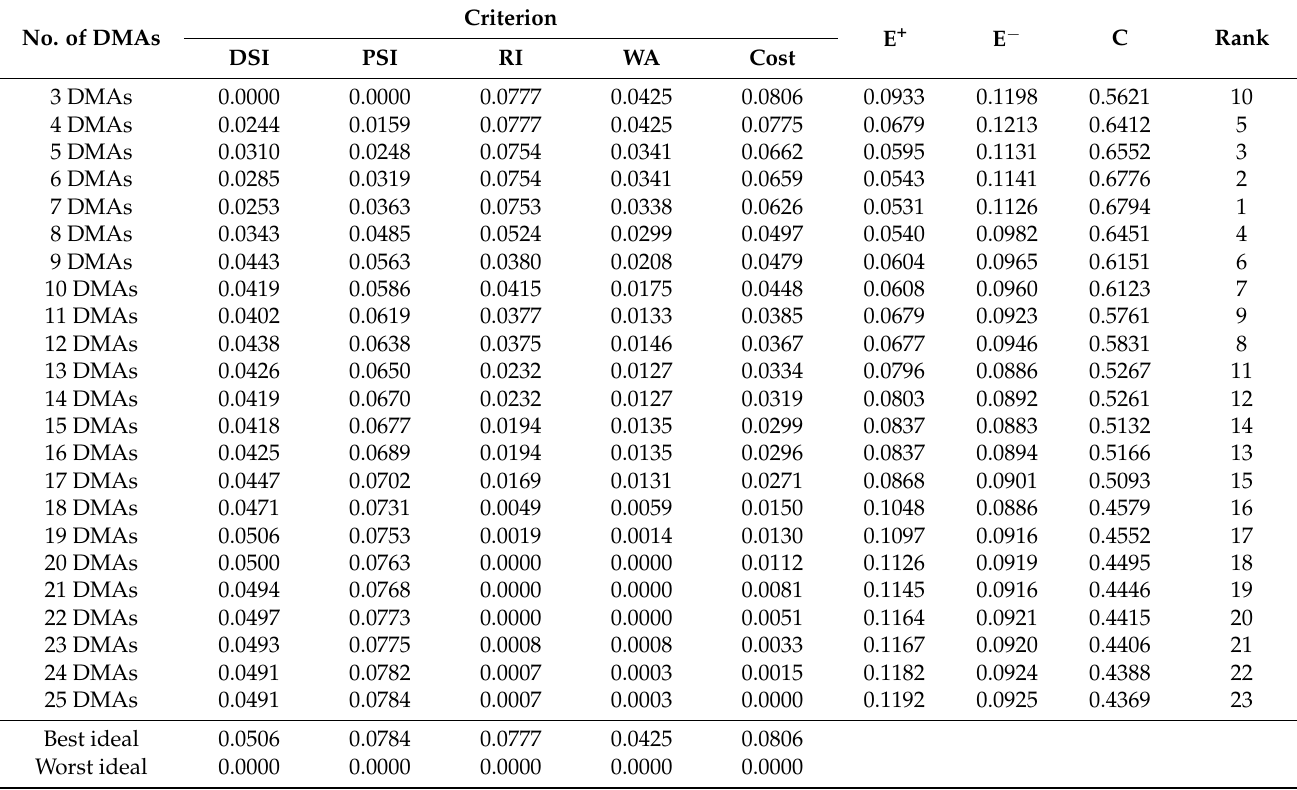
Table 6. Ranking of DMA layouts by the TOPSIS